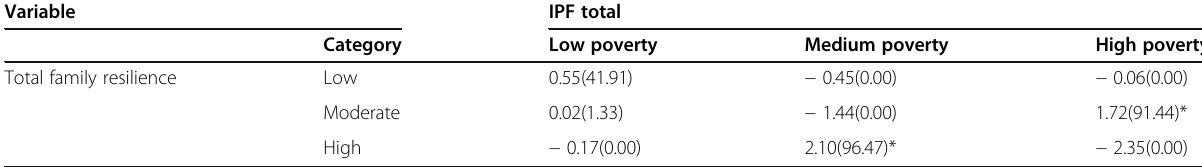
Table 3 Associations between Family Resilience and Family Poverty Rate